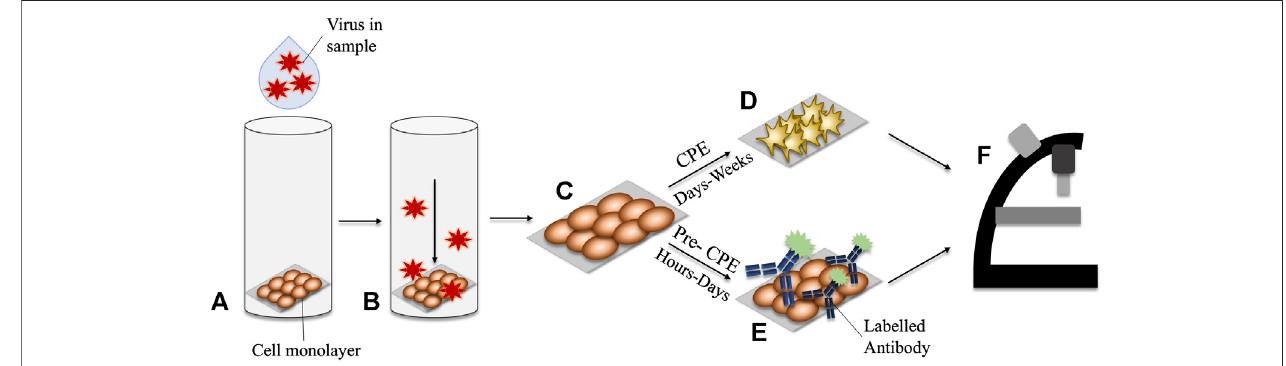
FIGURE 1 | Comparison of CPE vs Pre-CPE detection in shell-vial culture. (A) Virus-containing sample is applied to the shell vial. (B) A centrifugal force is applied, encouraginginoculationofthevirusintothecellmonolayer. (C) Themonolayercellsgrowingonaglassslidemayberemovedforinterrogation. (D) CPEmaytakedaysto weekstodevelopintheculturingcells. (E) Pre-CPEdetectionemployslabelledantibodiestoidentifyvirus-speci fi cmarkers;thesecanbedetectedwithinhours-days. (F) Microscopy can be used to inspect for morphological changes in CPE-diagnosis, or for signals arising from the presence of a labelled-antibody for pre-CPE